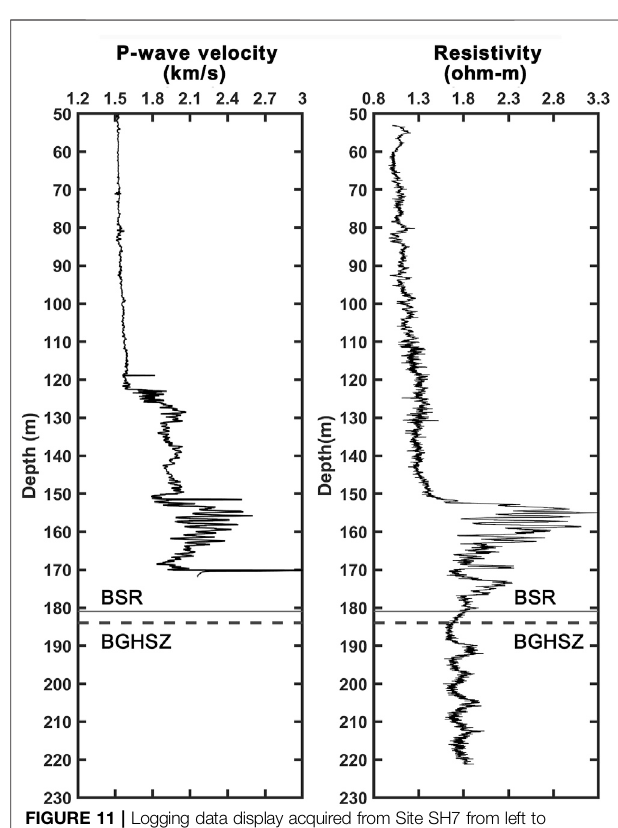
FIGURE 11 | Logging data display acquired from Site SH7 from left to right: P-wave velocity and resistivity. Solid line shows the depth of the bottom simulating re fl ector (BSR) and the dashed line shows the base of gas hydrate stability zone (BGHSZ).